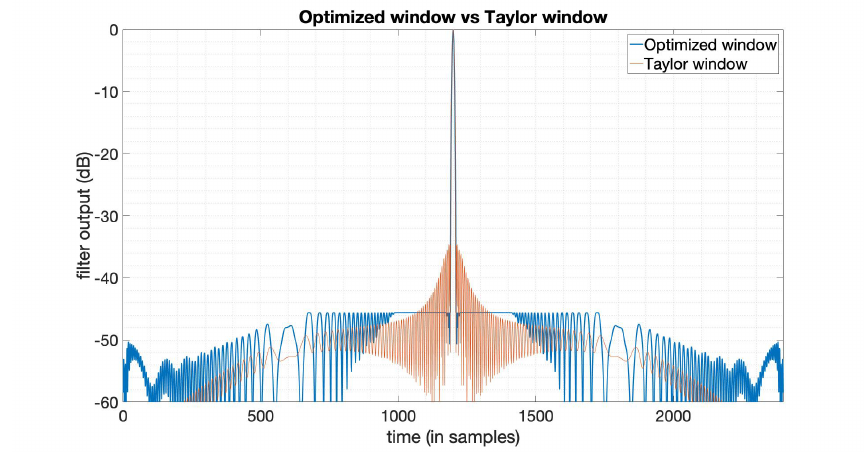
Figure 1. The output of the Taylor window (¯ n = 6,PSLR = − 35 dB) and the PSLR -optimized window.